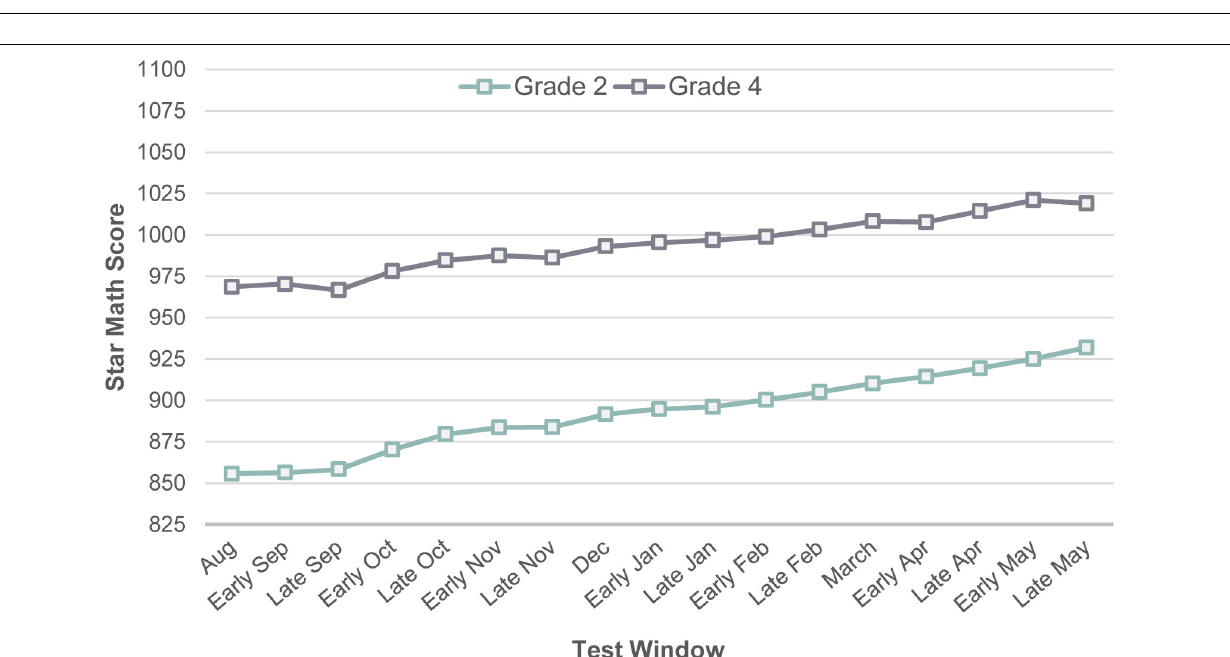
FIGURE 1 | Number of test administrations within the training dataset by test window.